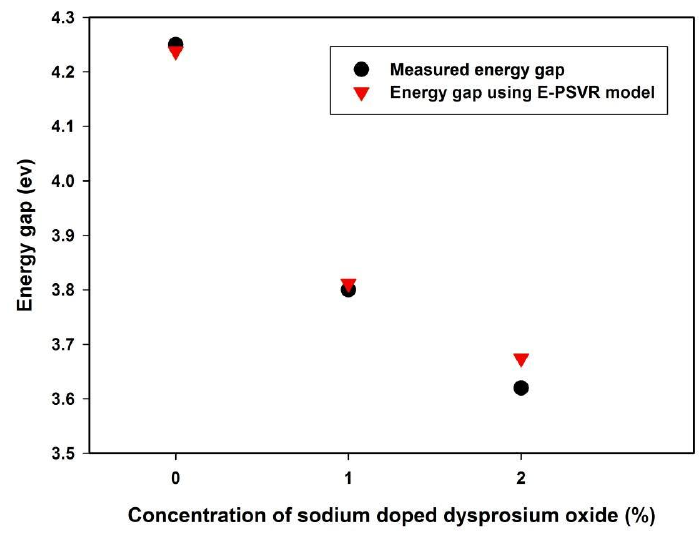
Figure 6. The effect of Na 2 Dy 2 O 4 dopant on the energy gap of polyvinyl alcohol.